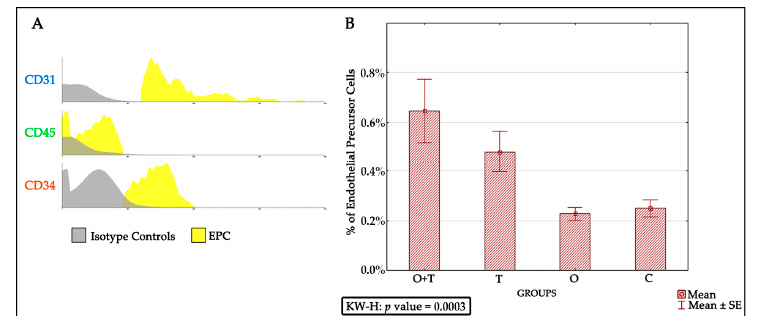
Figure 3. ( A ) Histogram of endothelial progenitor cells (EPCs) identified by CD31+, CD45 − , and CD34+; and ( B ) Graph showing percentages of endothelial progenitor cells in each group and the result of the Kruskal-Wallis statistical test (KW-H), p value = 0.0003. Table 2. Mann-Whitney post-hoc statistical test for the endothelial progenitor cells. Groups